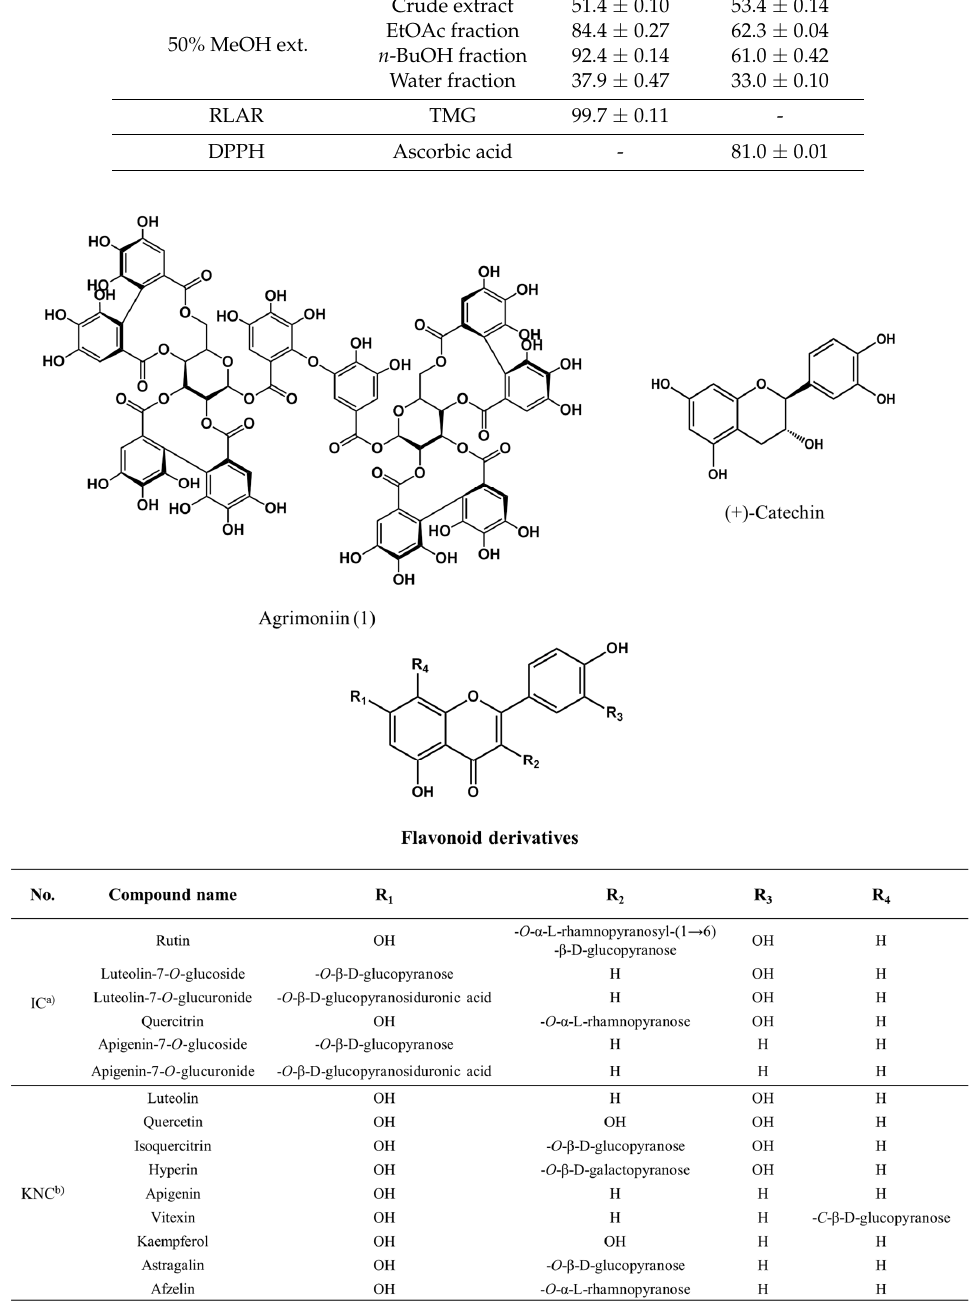
Figure 1. The structure of the compounds known and isolated from the n -BuOH fraction of A. pilosa Ledeb; a) IC is the compounds isolated from A. pilosa Ledeb; b) KNC is the known compounds isolated from A. pilosa Ledeb.